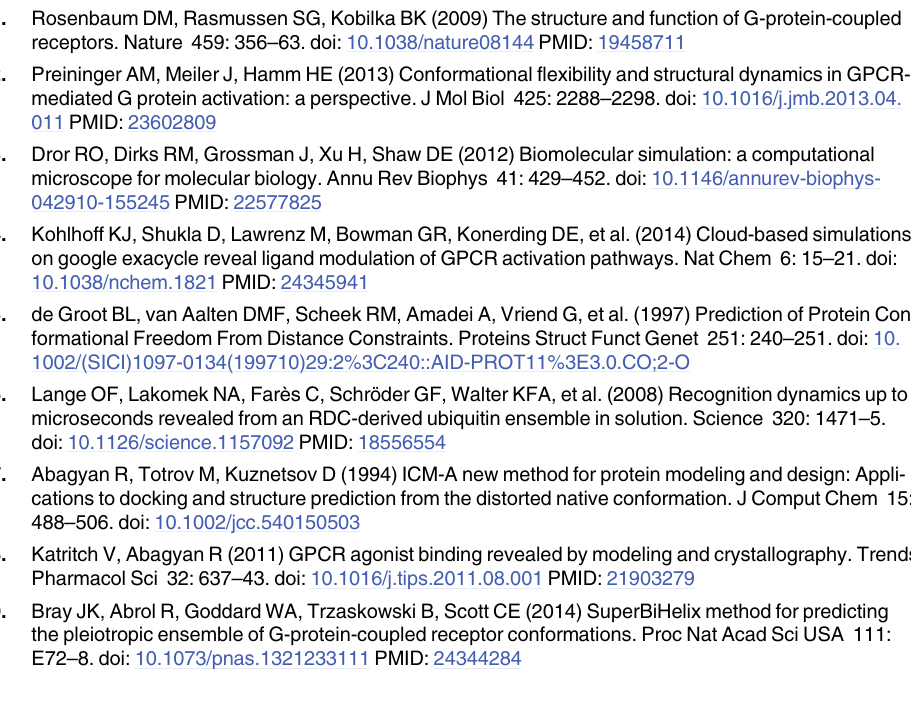
S5 Fig. Direction and magnitude of normalized mean displacements in KGS and iMC con- formational distributions for 50,000 KGS samples. Top panel. The relative frequency of the angles between KGS and iMC average displacements for each C α of the AH-domain in the inactive (grey) and active states (orange/yellow) is virtually unchanged in the larger KGS ensemble. Bottom two panels. The normalized magnitude of the mean C α displacement vectors of the KGS (50,000 samples) and iMC ensembles. The longer trajectories support stronger cou- , but otherwise are similar to those obtained from 20,000 samples. pling for helix α 5 (TIFF) S6 Fig. Anti-correlated motions between KGS and iMC at the N-terminus in the active state Ras domain. a) The proximity of the BC loop (red, with one residue in stick representa- (with one residue in stick representation) tion) in the AH domain and N-terminal helix α 1 results in ENM restraints for the active state crystal structure. b) A snapshot of the iMC confor- strand (red) is coupled to the AH domain, resulting in large motion mational ensemble. The β 1 amplitudes that deform the β -sheet.